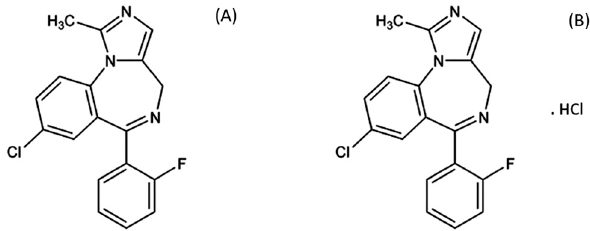
Figure 1: Chemical structure of midazolam (A) (Molecular weight (MW): 325.77 g·mol − 1 ) and its hydrochloride salt (B) (MW: 362.23 g.mol − 1